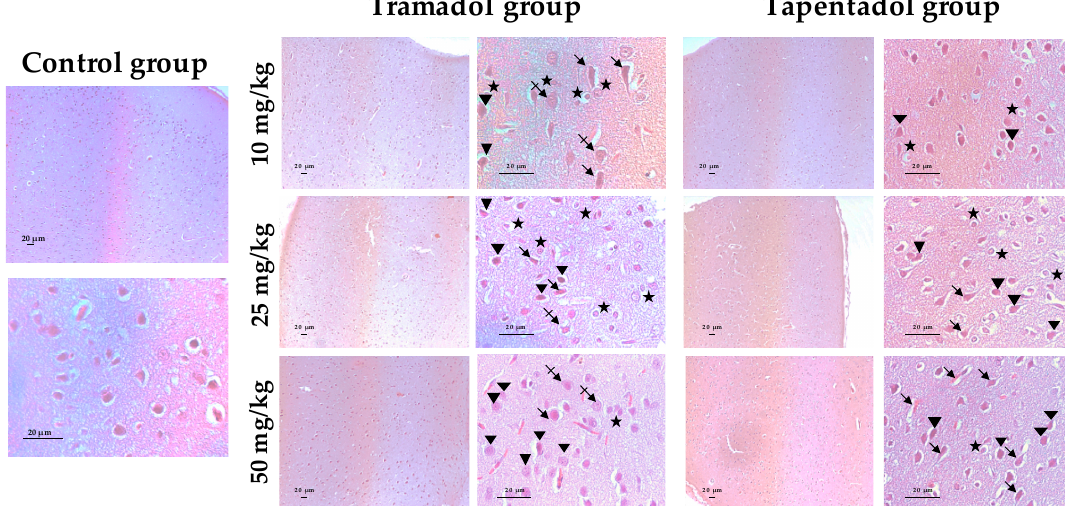
Figure 7. Photomicrographs of heart sections of Wistar rats intraperitoneally injected with different tramadol and tapentadol doses or saline (control group), for 14 consecutive days, upon Masson’s trichrome staining. Fibrous tissue (dotted arrows) and purple cell infiltrates (thick arrows), possibly corresponding to fibroblasts, as well as a dotted staining (vertical, crossed arrows), are observed among cardiomyocytes. Cardiomyocyte fiber filaments are disorganized and show heterogeneous pigmentation (double arrows). Increased perivascular spaces (arrow heads) are also observed. Photographs were taken with 100× and 600× magnifications. Scale bar, 20 μ m.